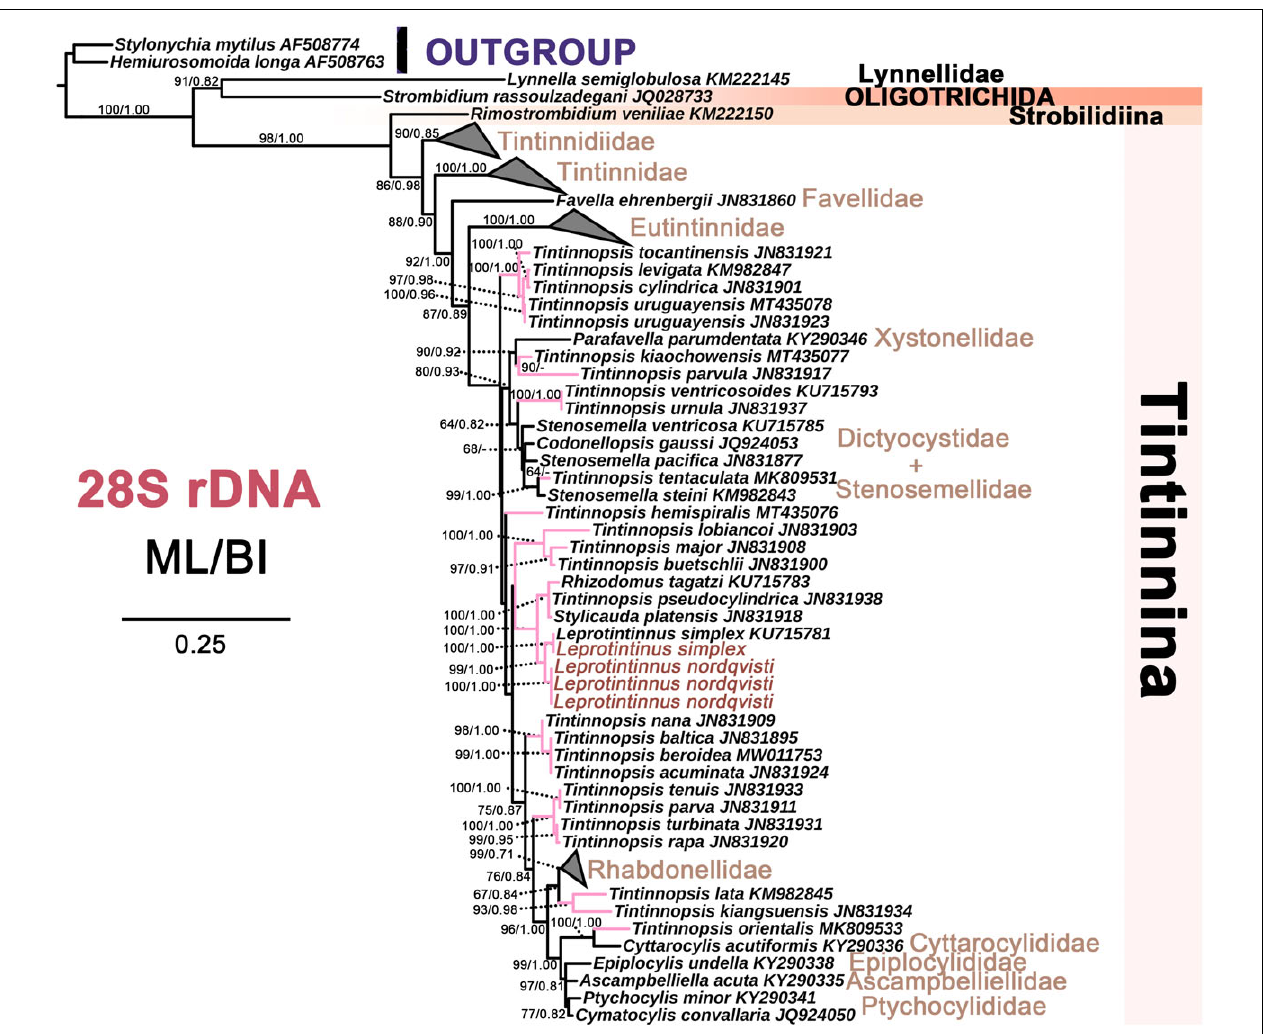
FIGURE 9 | The maximum likelihood (ML) phylogenetic tree is inferred from 28S rDNA sequences. Numbers at the nodes represent support values in the following order: ML and BI bootstrap values. The pink branch denotes the incertae sedis taxa in Tintinnina. The new sequences Leprotintinnus neriticus and L. simplex in the present work were indicated in red. A hyphen (–) represents support values too low (ML < 45%, BI < 0.70) and disagreements in topology between the BI and ML trees. The scale bar corresponds to 25 substitutions per 100